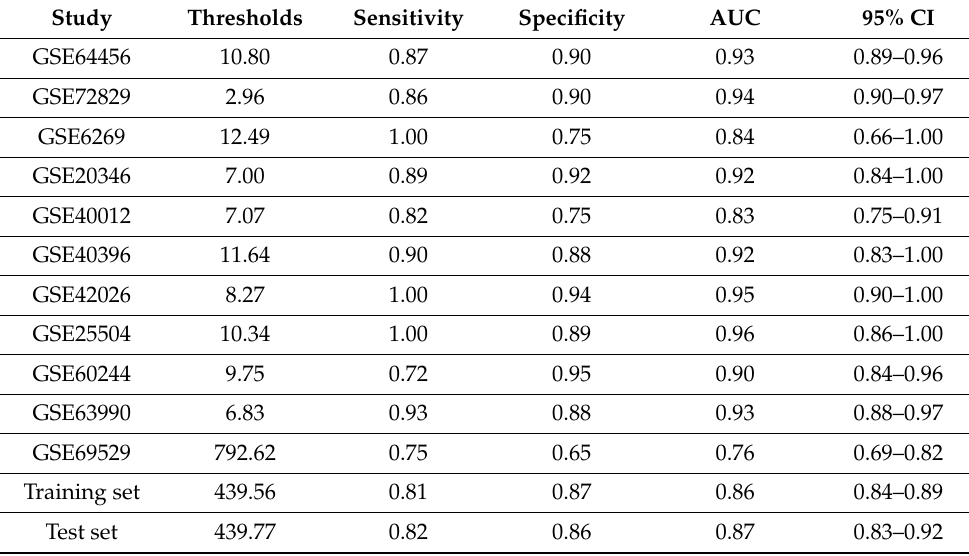
Table 2. AUC, sensitivity and specificity of the 3-transcript